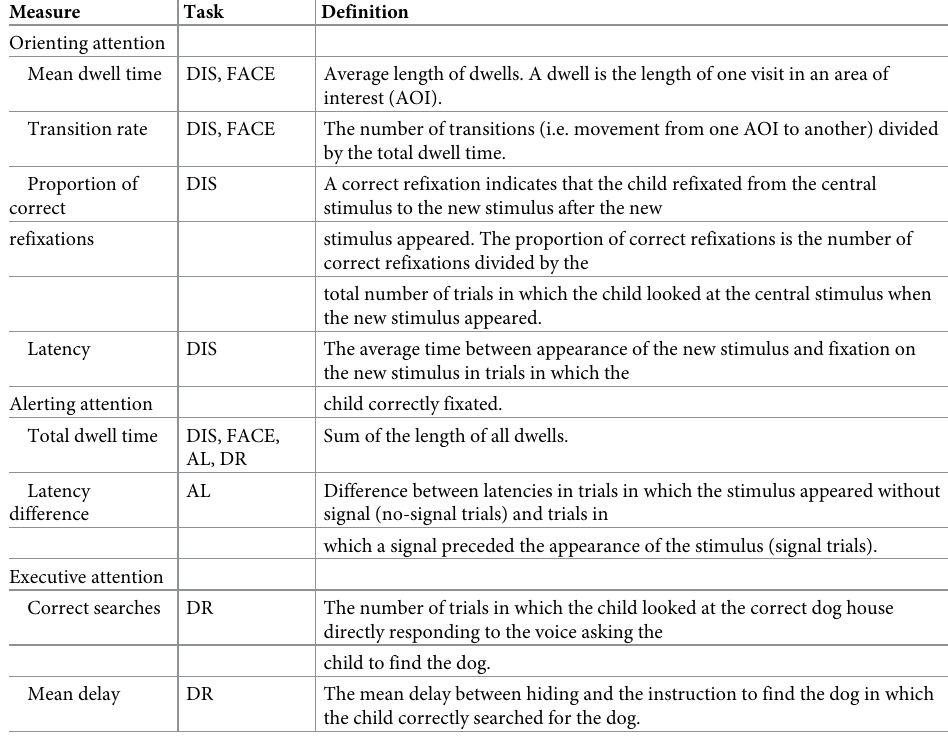
Table 2. Definitions of the variables from the